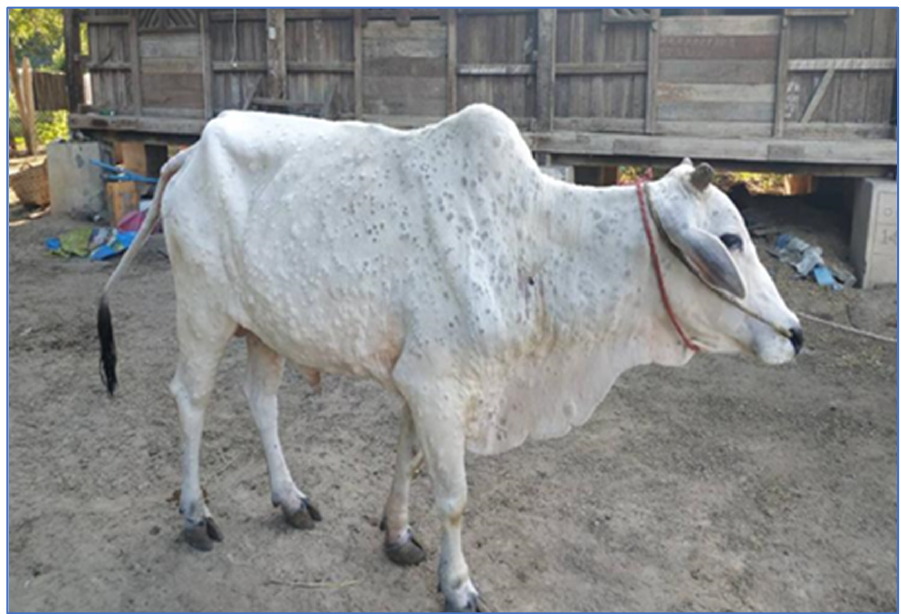
Figure 3. Bull in Myanmar with LSD lesions. Photo: Dr Ohnmar Aye (Assistant Director, LBVD, Tabayin township).